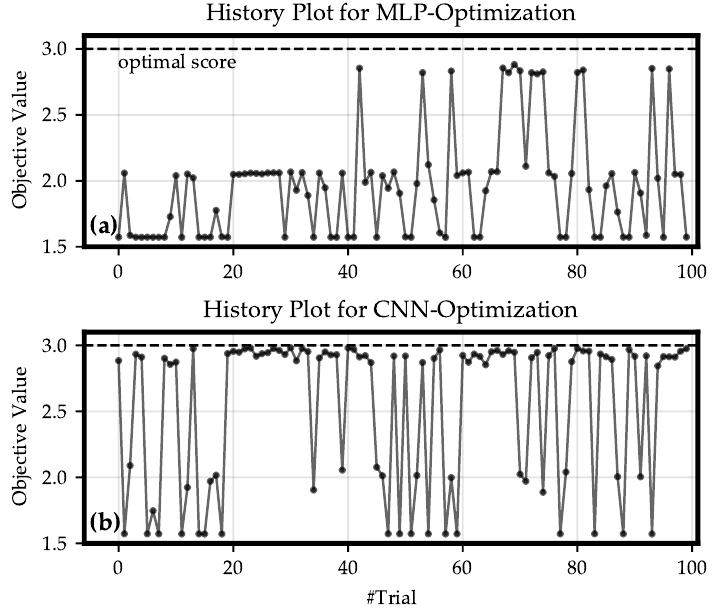
Figure 6. Comparison of MLP and CNN optimization regarding the history of the objective values for 100 trials. In ( a ) the less successful MLP optimization history is shown, while in ( b ) the objective values obtained in the CNN optimization are